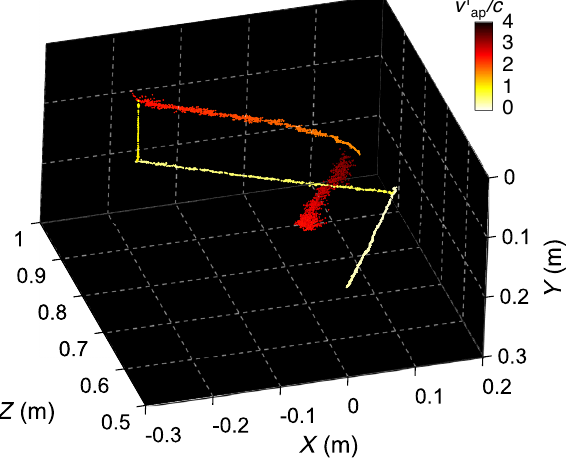
FIG. 5. Reconstructed apparent transverse velocity distribution in xyz space. The color of each dot corresponds to the locally estimated apparent transverse velocity, normalized by the speed of light in vacuum.